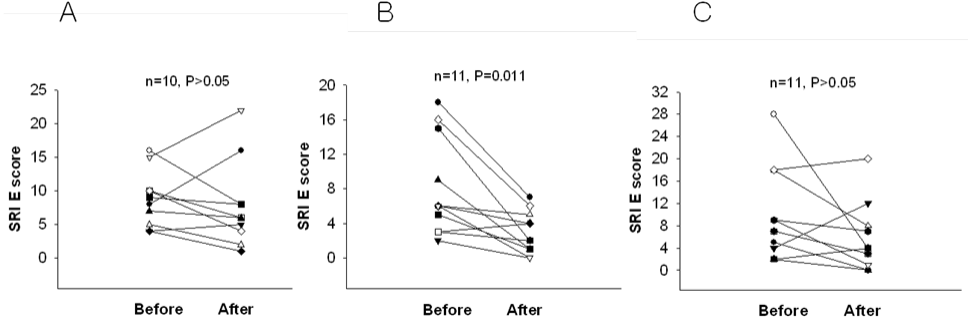
Figure 6. Differences in SRI E mean scores between WNS and placebo groups. ( A ) Placebo group, ( B ) 2.4 g of WNS group, ( C ) 4.8 g of WNS (B) 2.4 g of WNS group, ( C ) 4.8 g of WNS group.